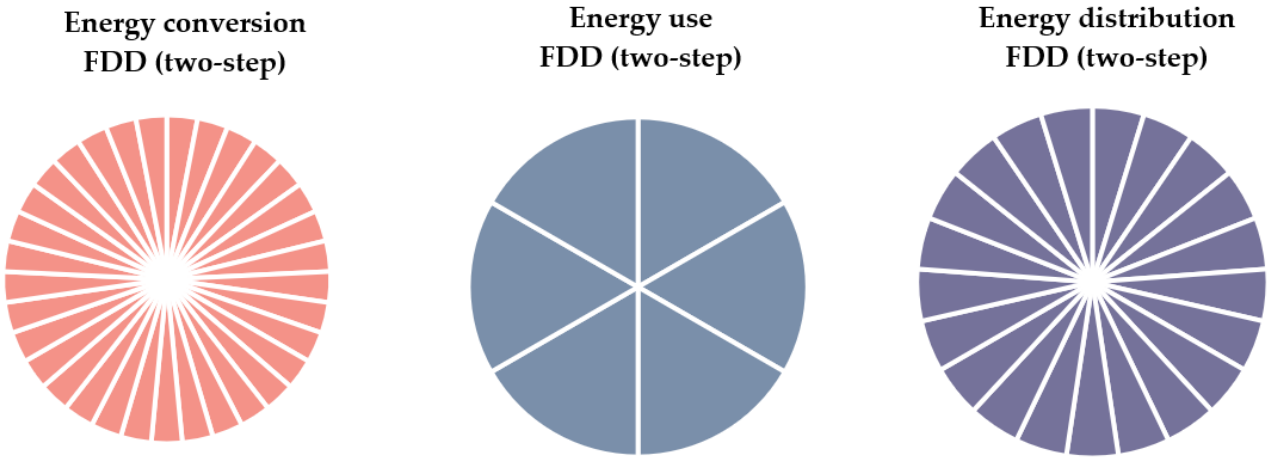
Figure 13. Energy-conversion, energy-distribution, and energy-use EST groups for two-step FDD.